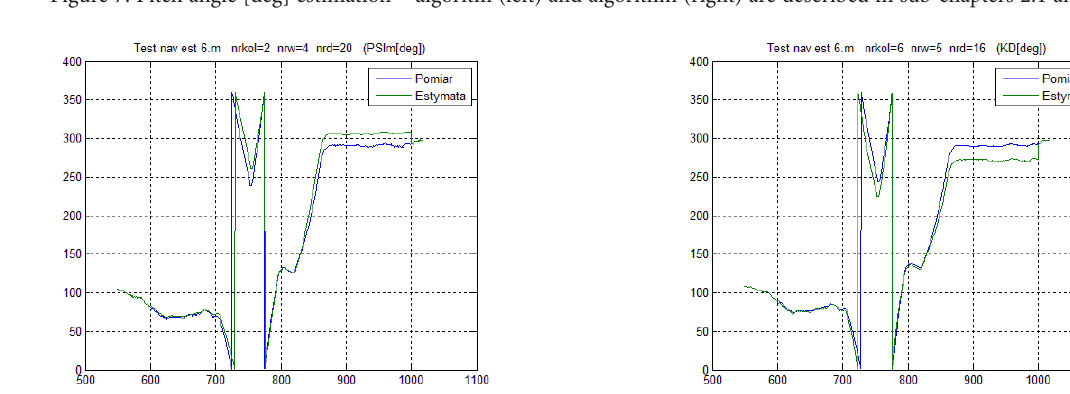
Figure 7. Pitch angle [deg] estimation – algoritm (left) and algorithm (right) are described in sub-chapters 2.1 and 2.2